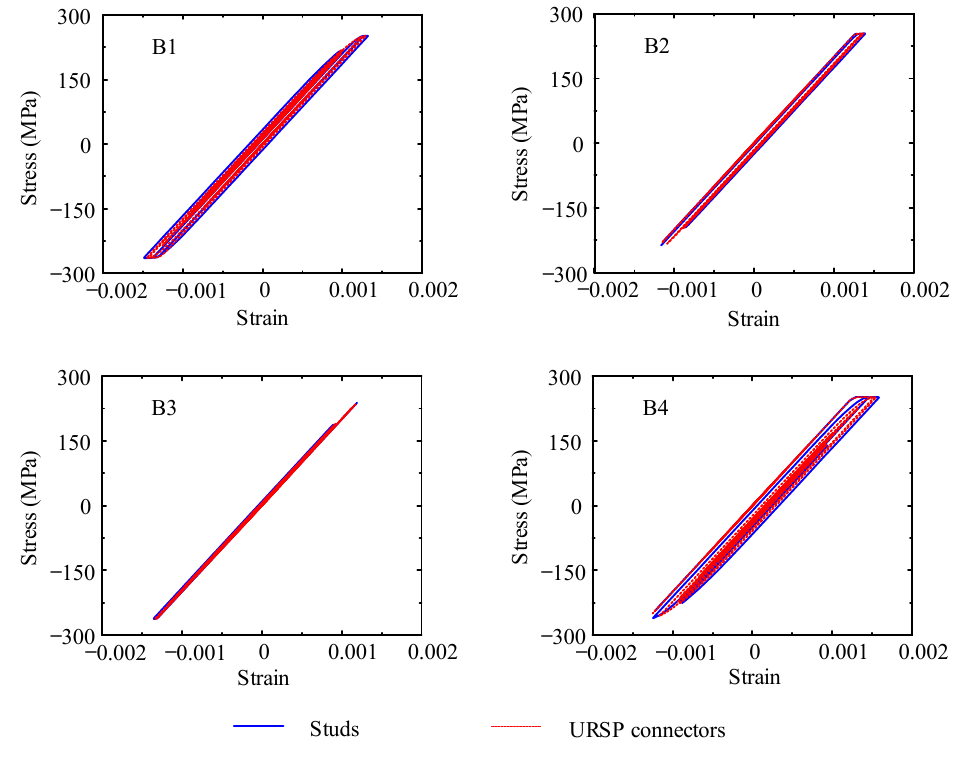
Figure 14. Numbering of key sections.